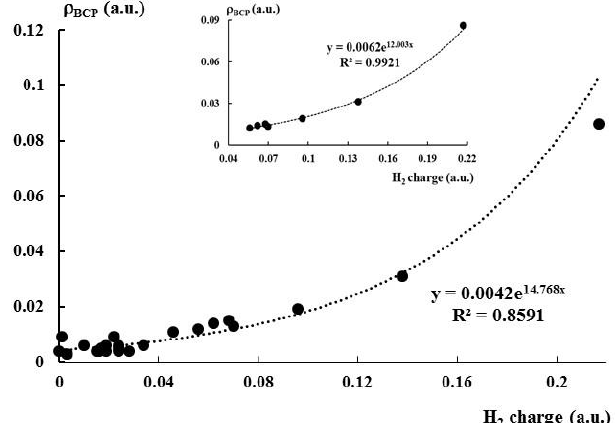
Figure 5. The exponential relationship between the H 2 charge (au) and the electron density at the intermolecular BCP (au); the greater scatter plot concerns the whole sample, while the smaller one concerns the sub-set of strong interactions.